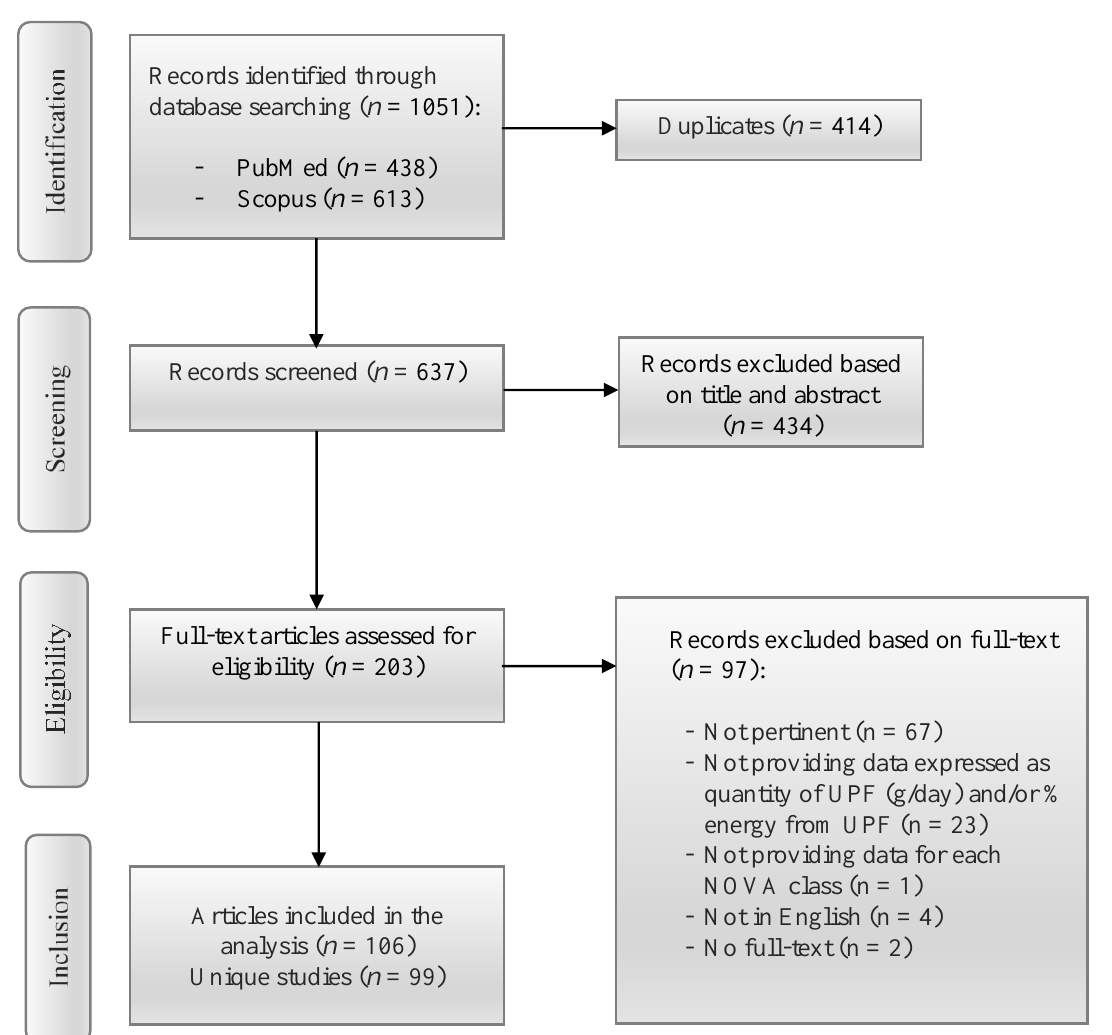
Figure 1. PRISMA flow diagram of the included studies.